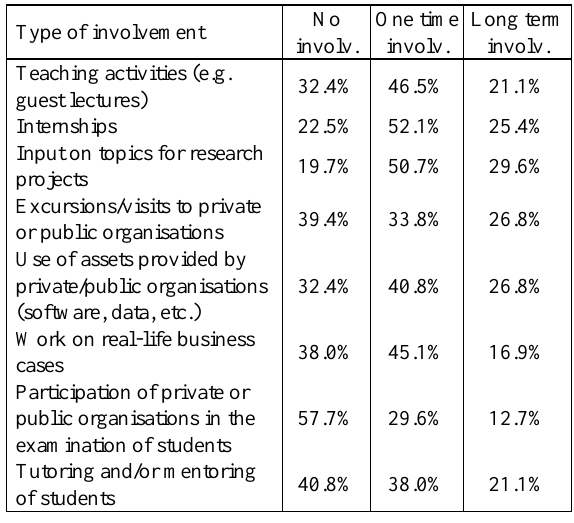
Figure 2. giCASES exploitation guiding questions (source: Martirano and Vercillo, 2017).